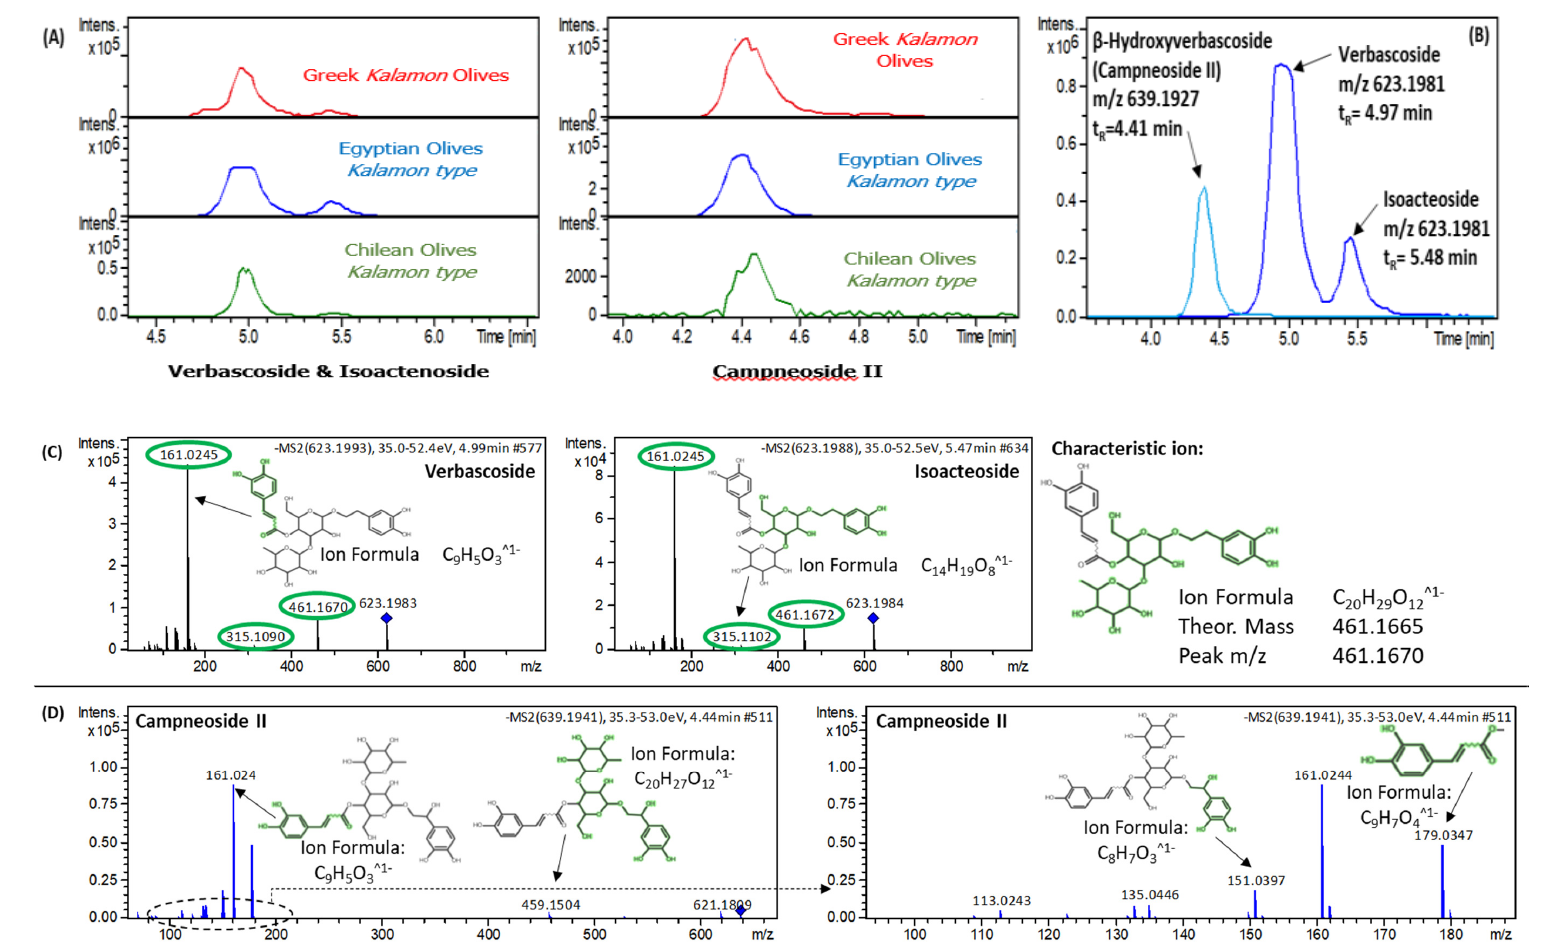
Figure 8. ( A ) abundance and ( B ) elution order of all phenylpropanoids in Greek, Egyptian, and Chilean table olive samples; ( C ) diagnostic fragment loss of caffeoyl moiety in Verbascoside and Isoacteoside; ( D ) MS/MS evaluation of Campneoside II.